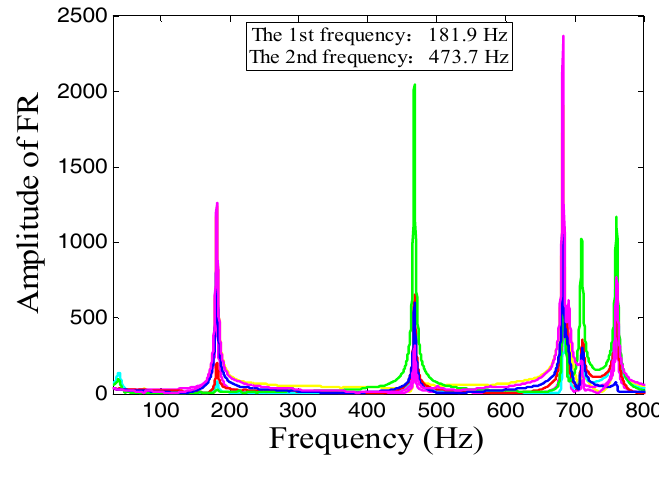
Figure 15. Measured test results. ( a ) Measured excitation; ( b ) Acceleration response.